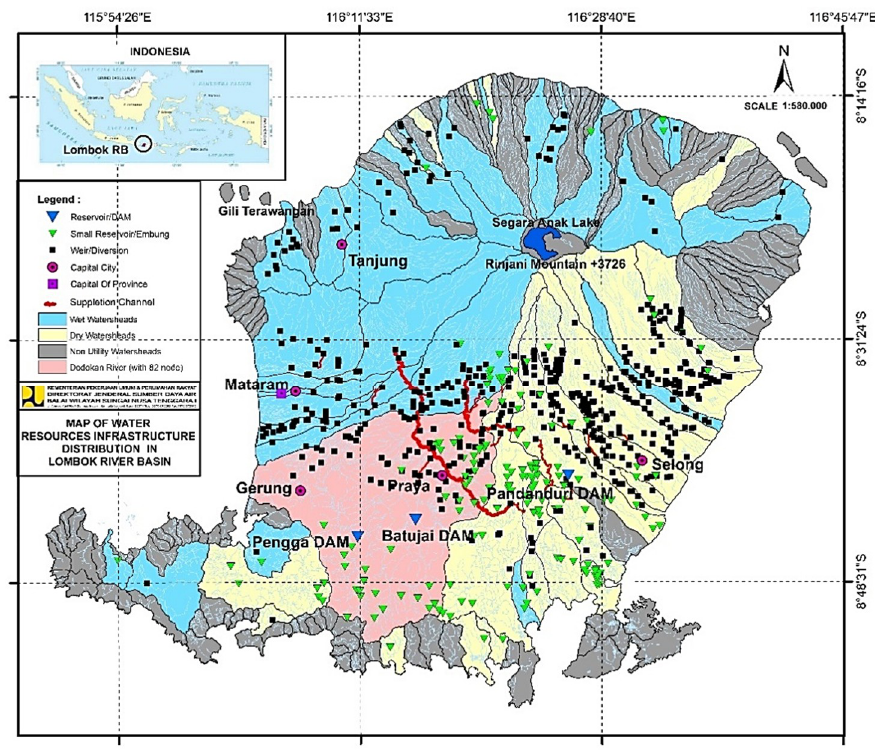
Figure 1. Lombok river basin with headwork nodes distribution.